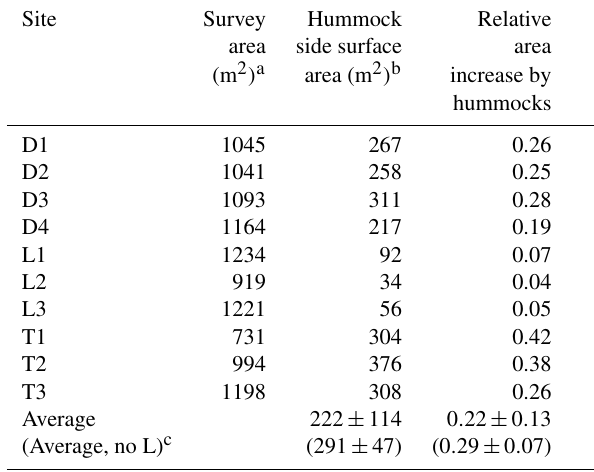
Table 3. Relative area increase by hummocks across sites.